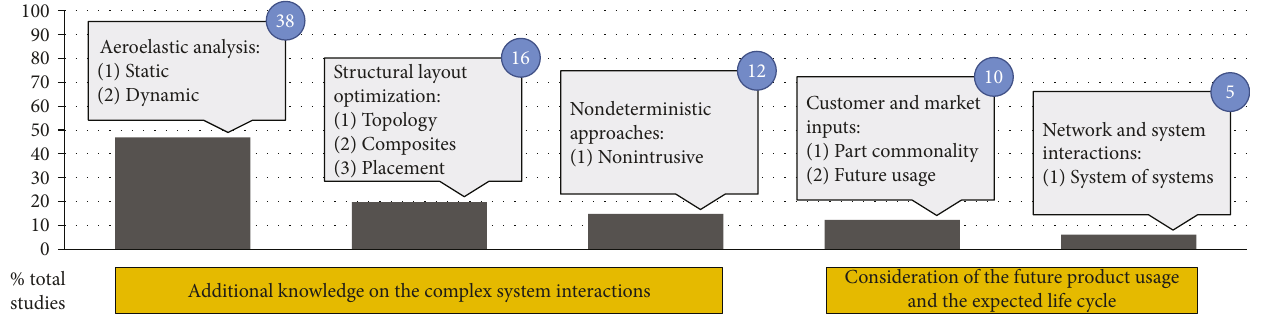
Figure 5: The main categories and the reoccurrence frequency of the analysis